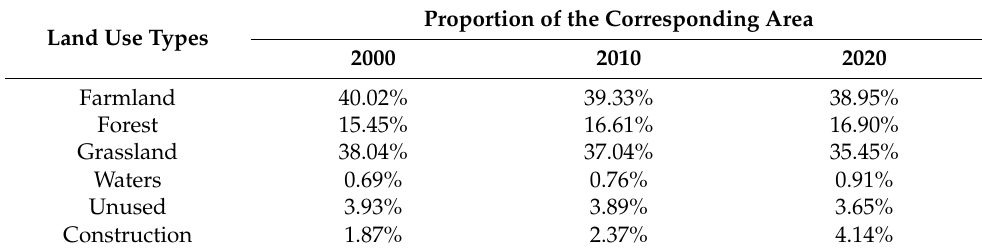
Figure 8. Spatiotemporal distribution of land use types of ( a ) 2000, ( b ) 2010 and ( c ) 2020 in the Loess Plateau. Table 4. Statistical results of different land types in the LP (2000–2020).